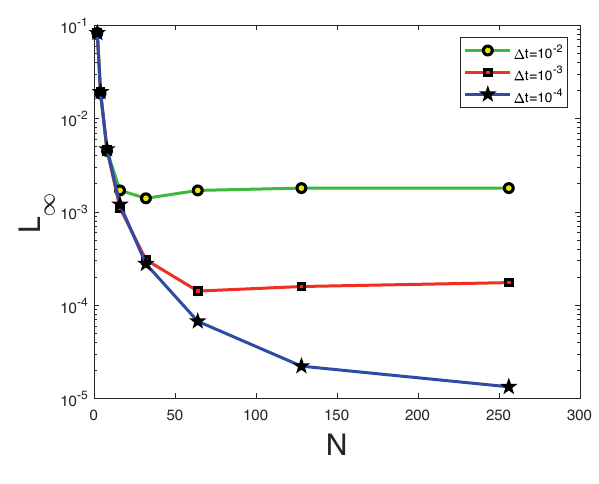
Fig. 5. L ∞ errors for different time-step sizes for Test Problem 6.